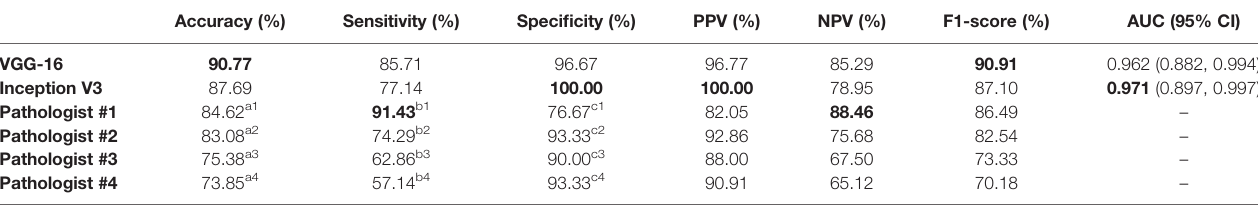
TABLE 3 | Performance of slide-level binary classi fi cation on testing dataset.